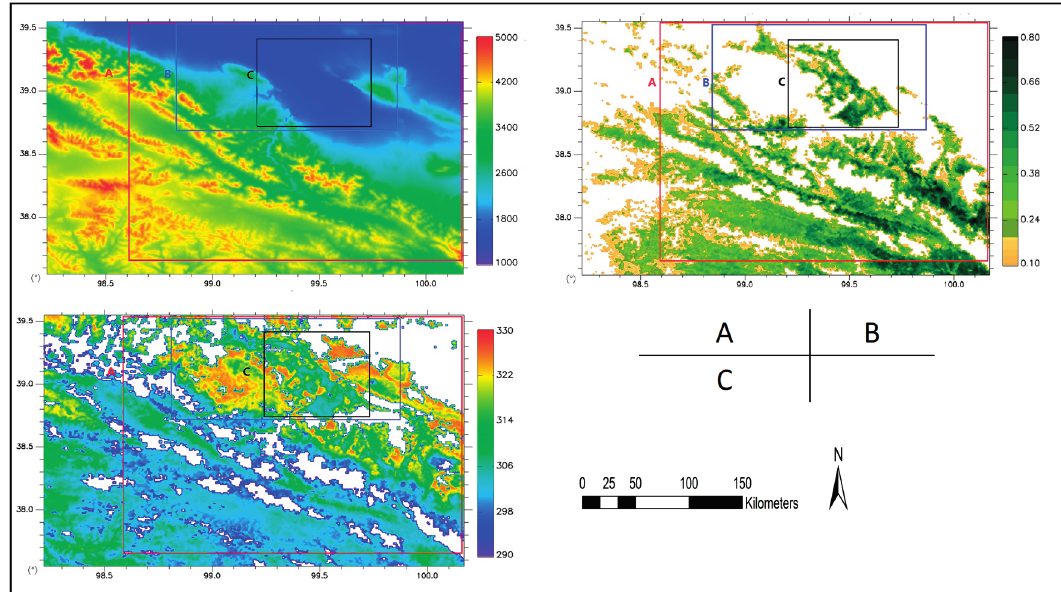
Figure 3. The spatial distribution of ( A ) Digital Elevation Model (DEM) (unit: m); ( B ) Fc and ( C ) LST (unit: K) in the entire study area. The three rectangles (A), (B), and (C) indicate the nested windows to build the LST-Fc feature